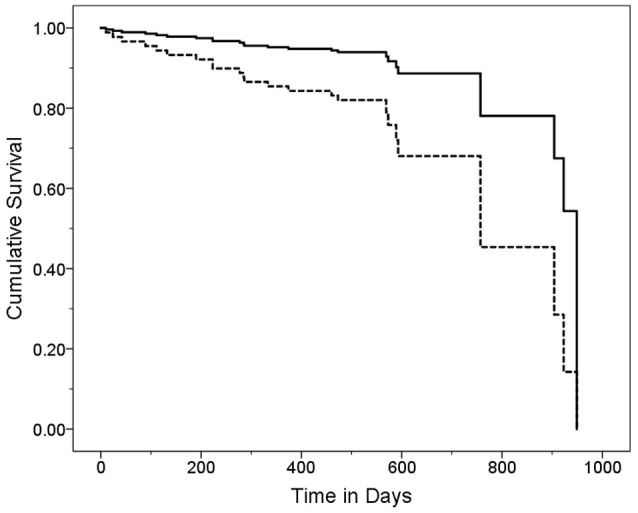
Survival Curve by GDS Category. ET cases were stratified into two GDS categories based on the median GDS score (GDS = 5). Cases with higher GDS scores (solid line) had a mean ± standard deviation [median] GDS score = 10.9 ± 5.0 [9.0] years and cases with lower CDR scores (dashed line) had a mean ± standard deviation [median] GDS score = 2.6 ± 1.7 [3.0] years. Hazards ratio (95% Confidence Interval) in Cox proportional-hazards model = 3.20 (1.18–8.67), p = 0.02.